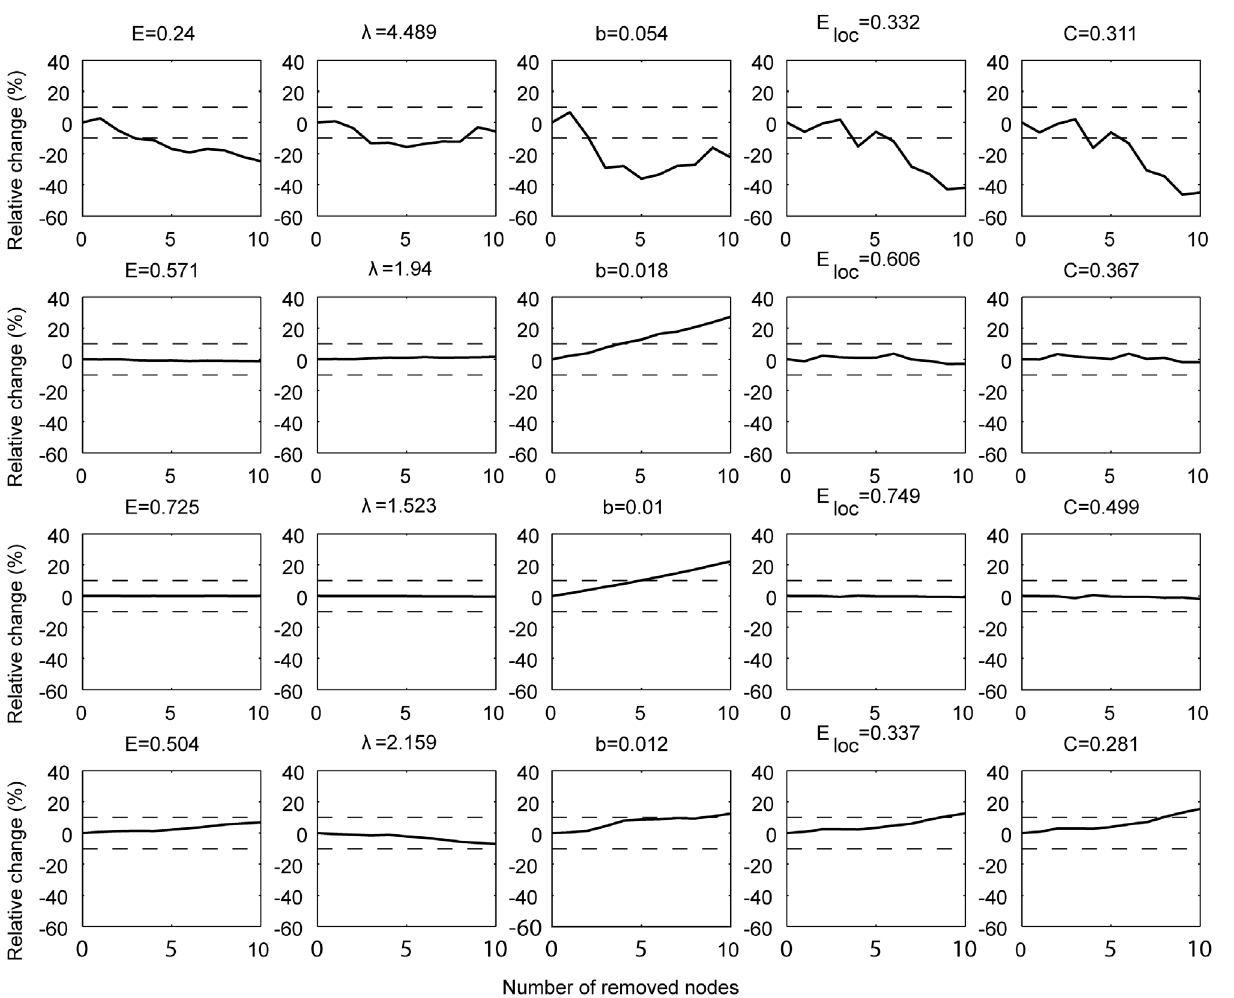
Fig. 7. Robustness to missing nodes for networks with an initial density of 5% (top row), 20% (second row), 45% (third row) and the weighted network (bottom row). The relative change (%) to the value obtained when taking the intact network as the reference is shown. The nodes were removed based on their significance in the main effect of task (starting with the least significant ones). Dotted lines indicate the + 10% interval. Relative changes significantly ( p cor v 0 : 05 ) lower than 10% in absolute value are indicated with